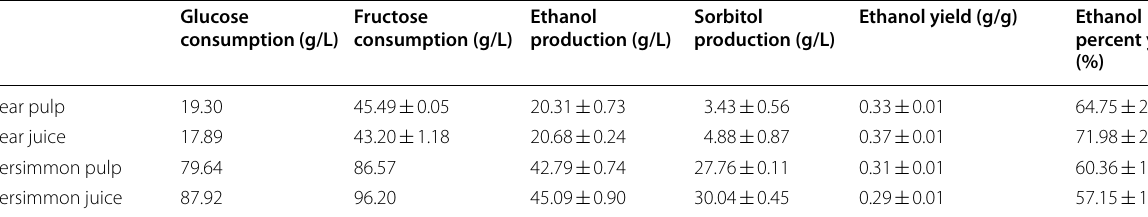
Table 3 Sugar consumption as well as the production of ethanol and sorbitol of Z. mobilis in fruit juice and pulp